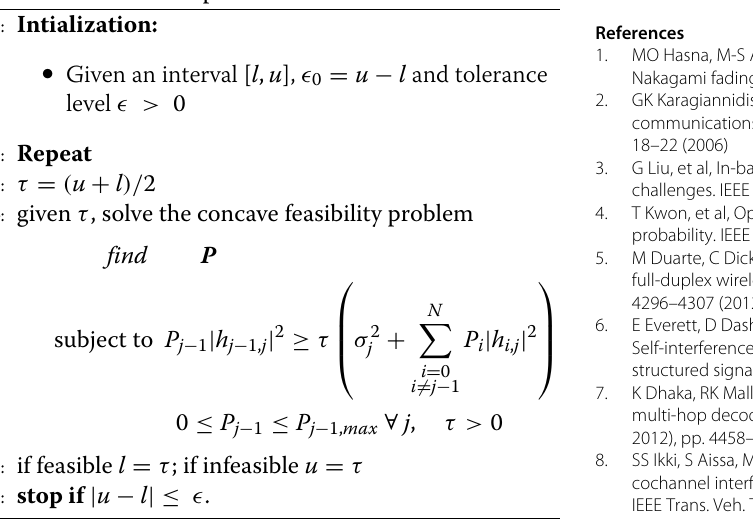
Algorithm 2 Iteratve algorithm for OPA based on Bisec- tion method: multi-hop